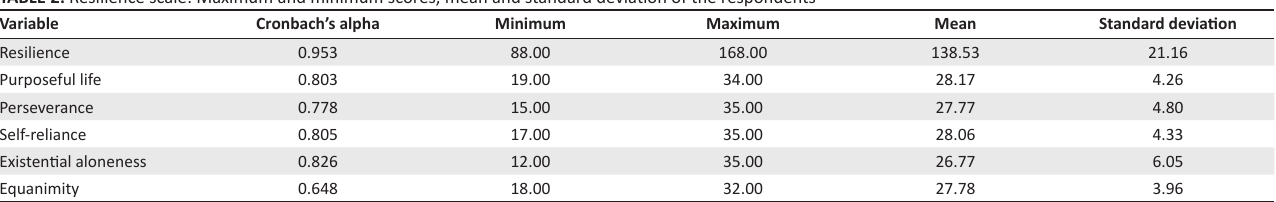
Existential aloneness